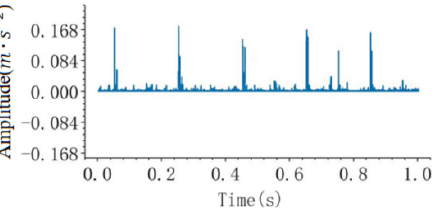
Figure 7. Time domain diagram of sparse decomposition results of MC.